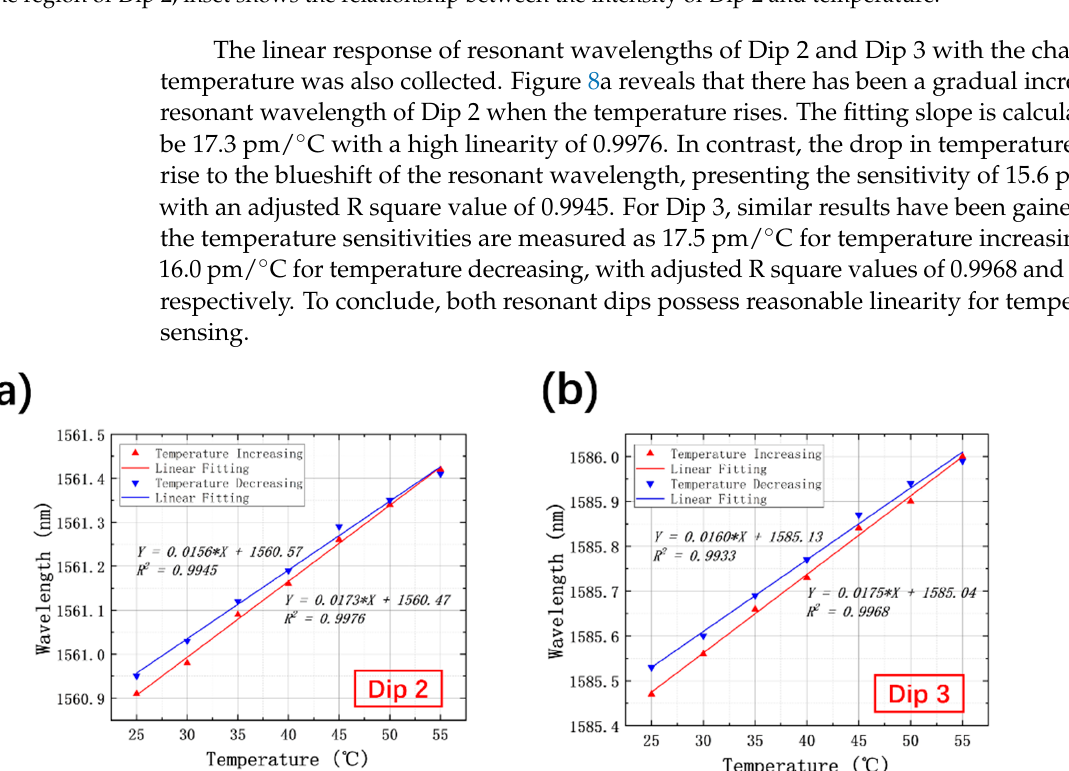
Figure 8. Relationship between the wavelength of resonant dips and temperature with temperature increasing and decreasing for ( a ) Dip 2 and ( b ) Dip 3.